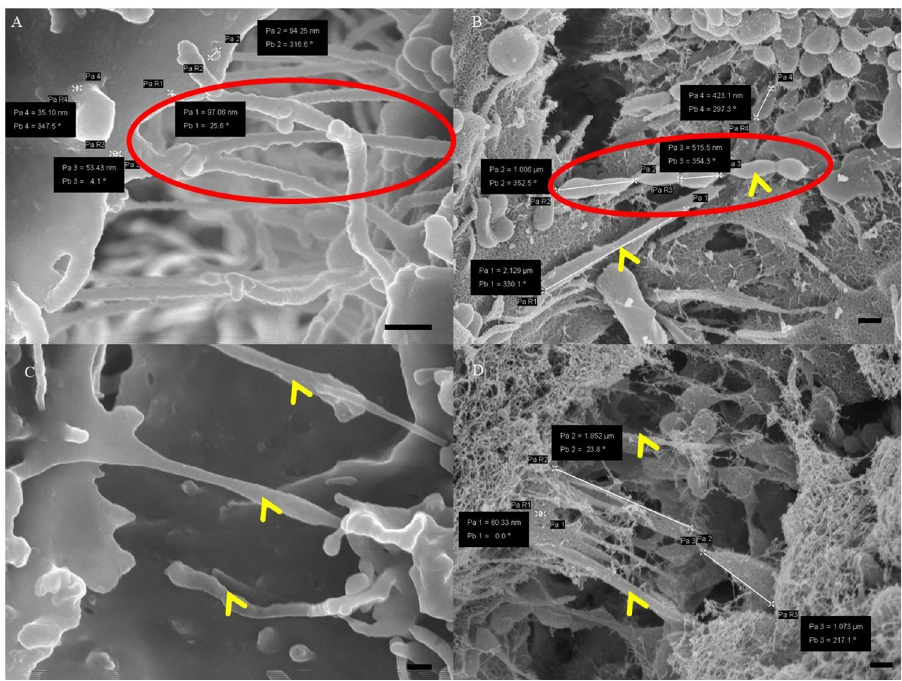
Fig 7. A micrograph representing apicolateral membranous projections between adjacent BECs grown on a Millicell insert membrane. (A) An image of a carbon-coated NT formation, showing smooth, indistinct leading edges, continuous with the cell membrane, see “red circle.” Scale bar = 300 nm; (B) An image of a Au:Pd coated leading edges where more textured lateral vesicles fuse into distinct cytoplasmic projections, see “red circle,” within the PC space, as indicated by the “yellow arrows.” Scale bar = 300 nm; (C) An image of a carbon-coated cytoplasmic projections (CPs) within the PC spaces, see “yellow arrowheads.” Scale bar = 200 nm; (D) An image of Au:Pd coated CPs, indicated by the “yellow arrows.” Scale bar = 300 nm.